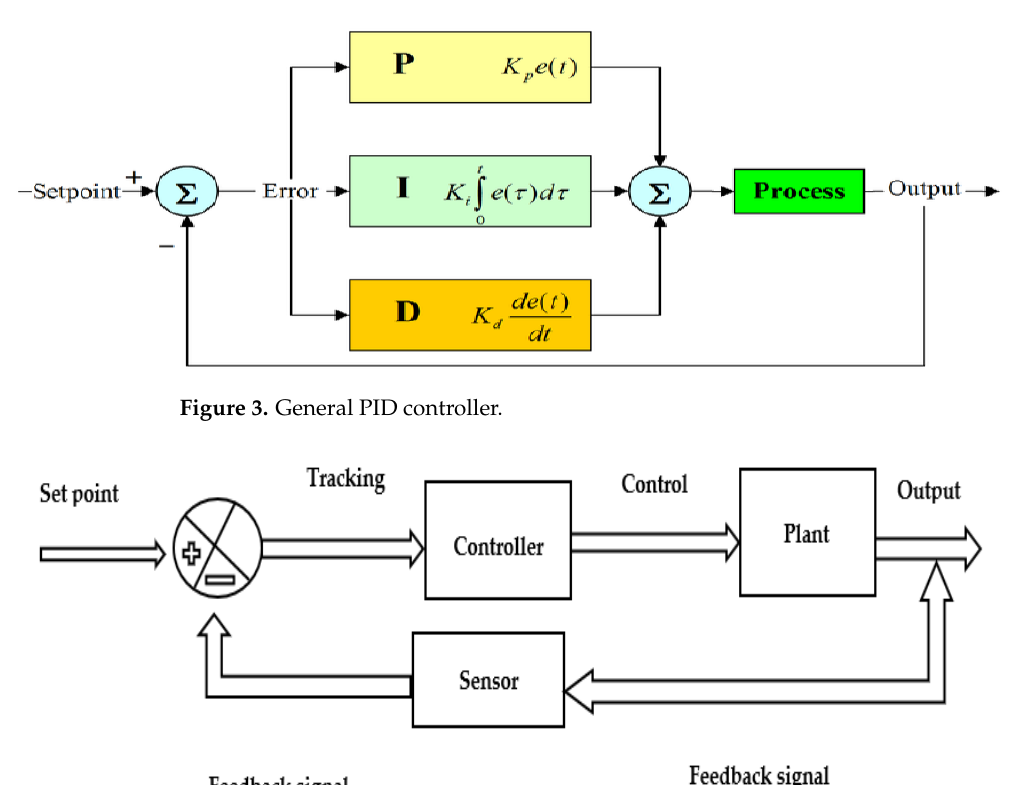
Figure 3. General PID controller.